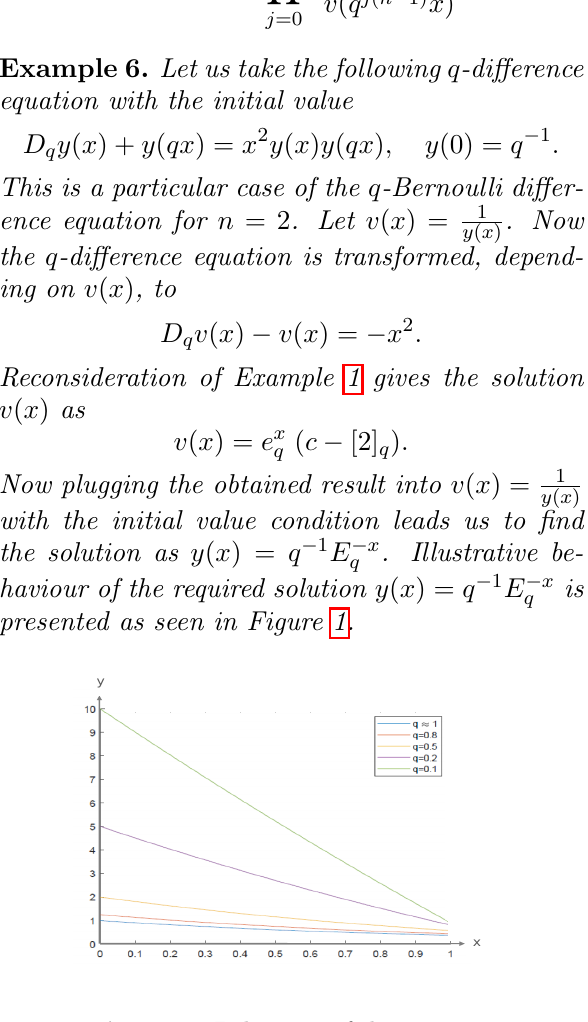
Figure 1. Behaviour of the response for various q values in Example